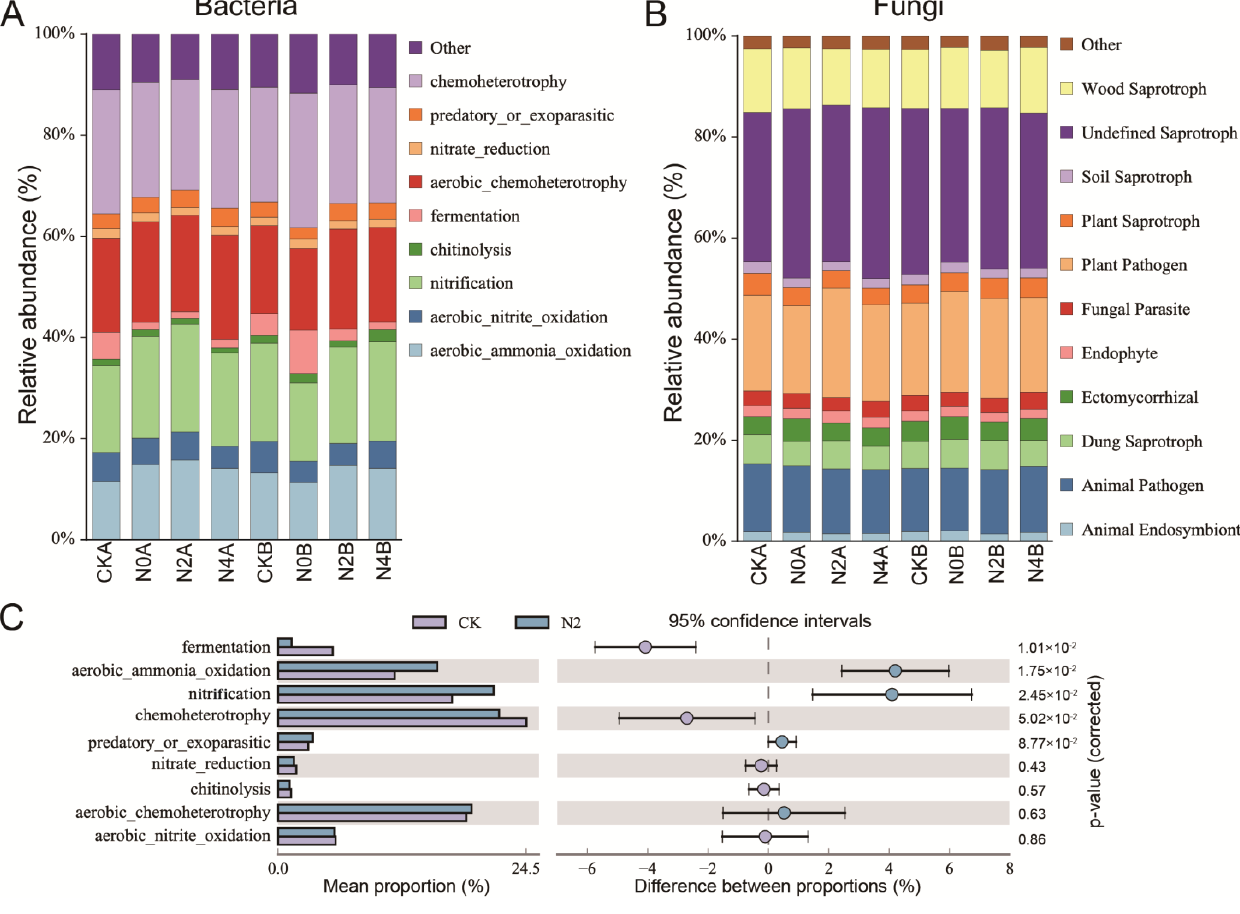
Figure 9. Functional analysis of bacteria and fungi. ( A ) The main function component of bacteria. The horizontal axis represents different samples. The vertical axis represents the relative abundance. ( B ) The main function component of fungi. The horizontal axis represents different samples. The vertical axis represents the relative abundance. ( C ) Significance test of functional differences between CK and N2 treatment. The bar chart on the left represents the difference in function. The blue bars are N2 treatments. The purple bars are CK. The length of the bars represents the relative abundance. The significance test of differences in 95% confidence intervals is shown on the right. The horizontal axis represents the fold change. The vertical axis represents the p -value.